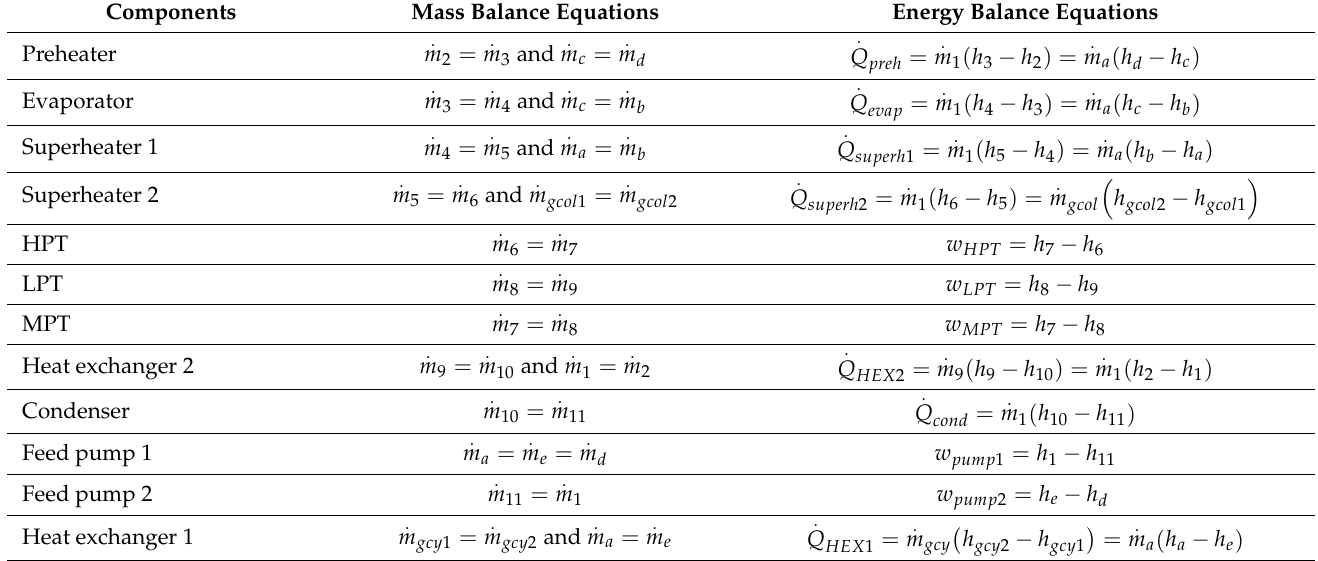
Table 3. Mass and energy balance of KCB system.